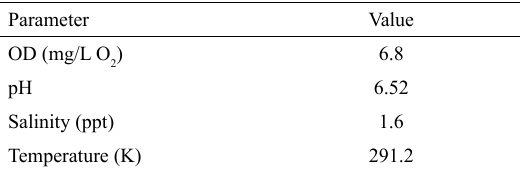
Table 2. Physical-chemical analysis of the natural ambient during period of biofouling analysis.